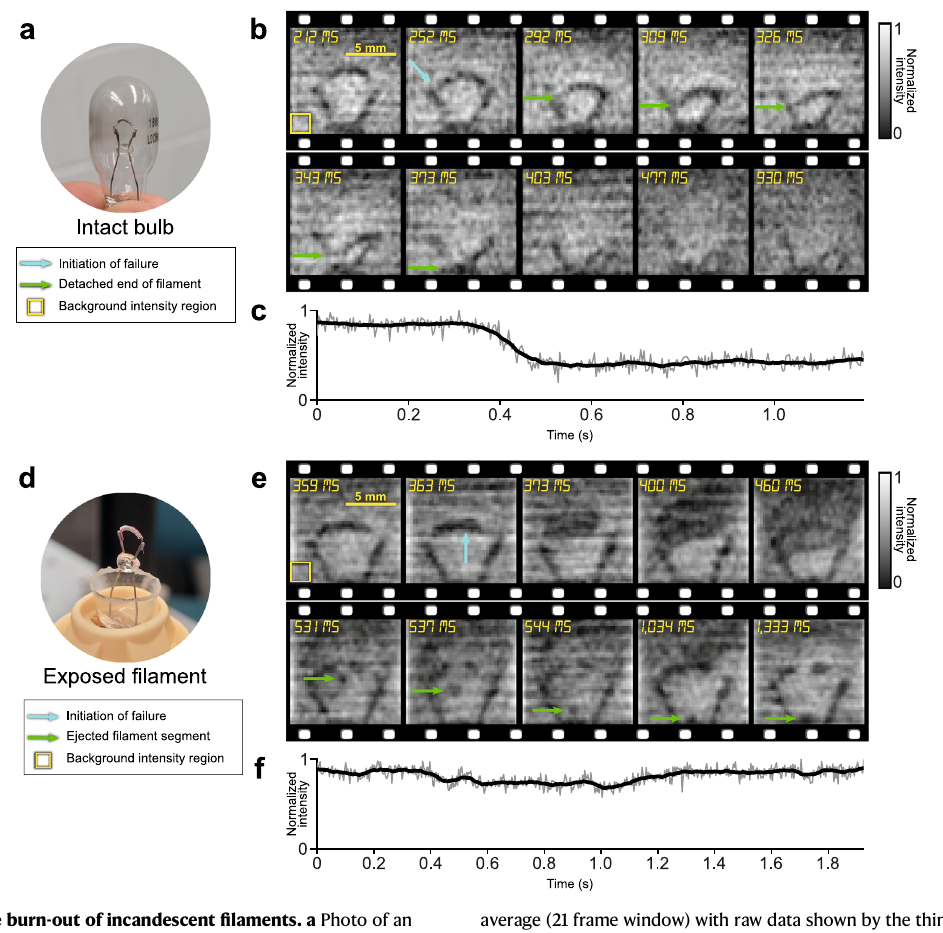
average (21 frame window) with raw data shown by the thin line. d Photo of a modi fi ed bulb showing direct exposure of fi lament to air. e Selected frames of the reconstructedvideoofthemodi fi edbulb. f As( c ),butfromthebackgroundregion in ( e